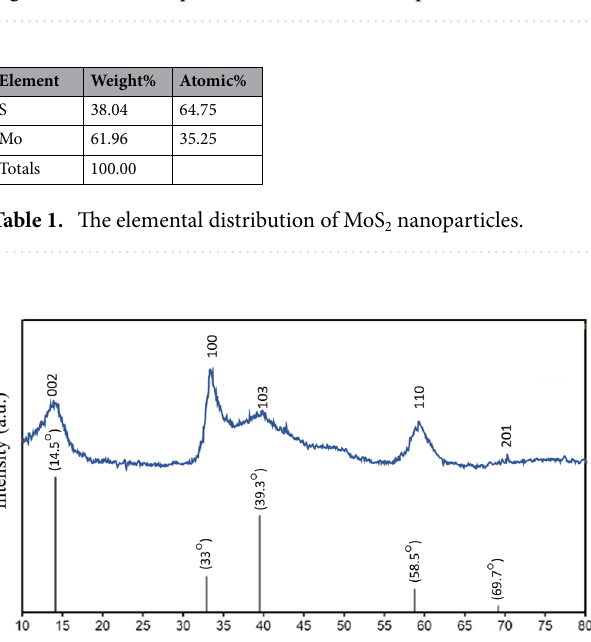
Figure 2. The EDS Spectrum of the MoS 2 nanoparticles.